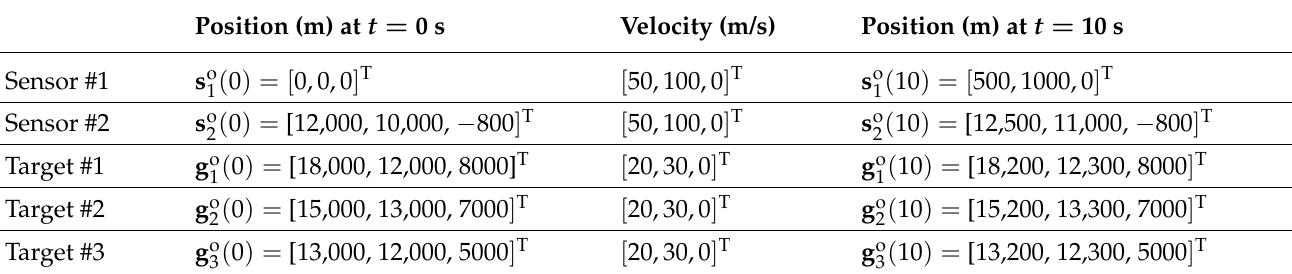
Table 1. Positions and velocities of sensors and